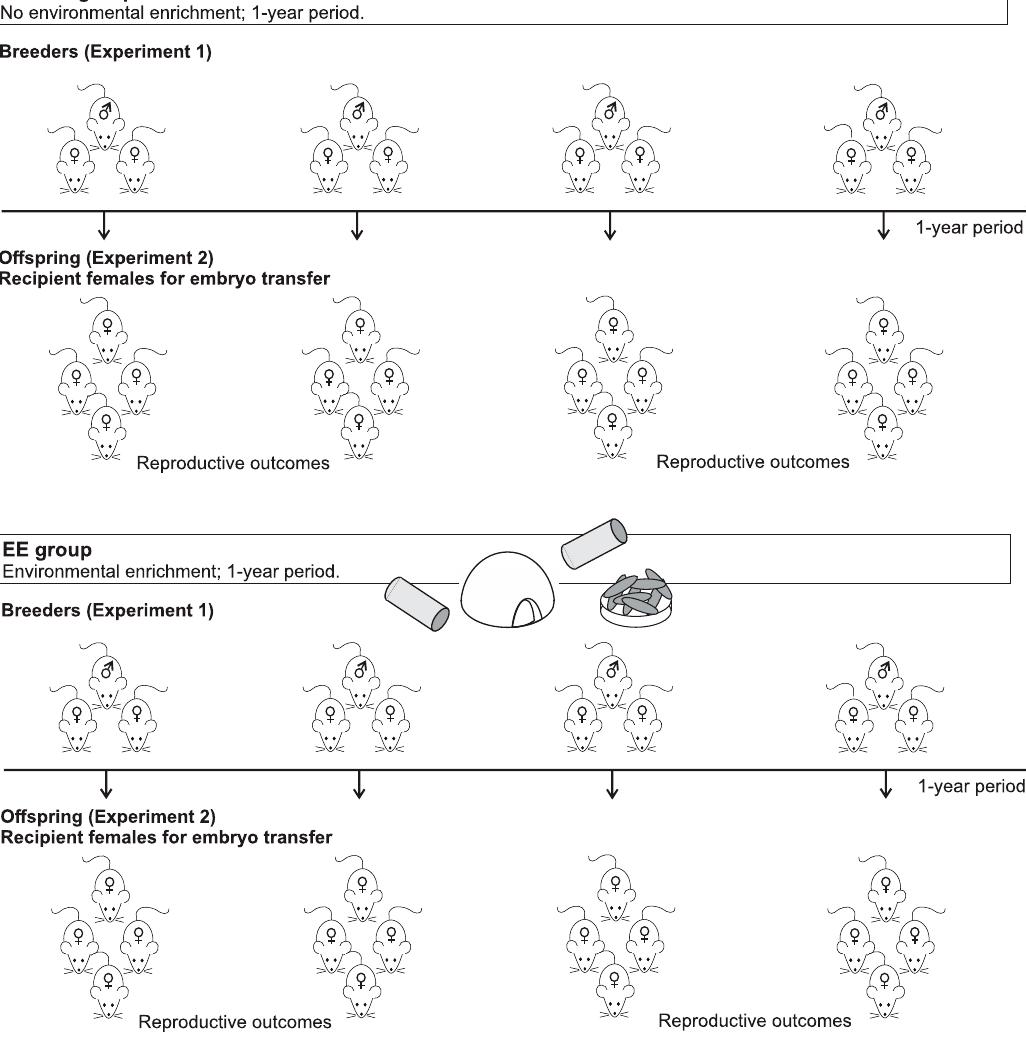
Figure 1. Schematic representation of the experimental design. In Experiment 1, Swiss Webster breeder trios were exposed (environmental enrichment (EE) group) or not (control group) to an environmental enrichment (EE) program. During 1-year period a total of 18 trios (nine per experimental group) were compared throughout their reproductive life. Reproductive outcomes such as time to first litter, interlitter interval, birth rate, litter size, number of pups weaned and pup’s weight were registered. In Experiment 2, female offspring that were born from Experiment 1 (i.e., with or without EE) were used as recipients for embryo transfer. Recipient females continued with (EE group, n = 35) or without (control group, n = 25) EE during growth, embryo transfer, pregnancy and delivery until pup’s weaning. Pregnancy and birth rate, litter size number and number of pups weaned were compared between both experimental groups.